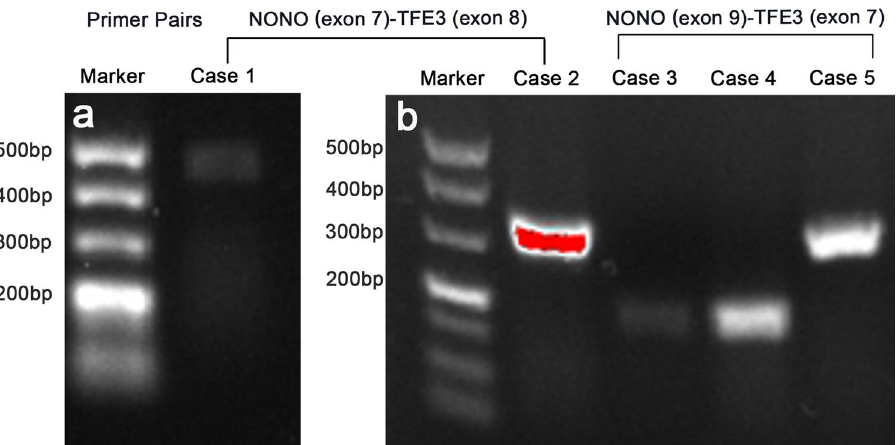
Figure 5. ( a )The results of reverse transcriptase–PCR showed a 500 bp targeted NONO-TFE3 transcript by the primer pairs NONO exon 7 (F) and TFE3 exon 8 (R); ( b ) Case 2 showed a 300 bp targeted NONO-TFE3 transcript by the primer pairs NONO exon 7 (F) and TFE3 exon 8 (R), while 3, 4 and 5 showed respectively 200 bp and 500 bp targeted NONO-TFE3 transcript by the primer pairs NONO exon 9 (F) and TFE3 exon 7